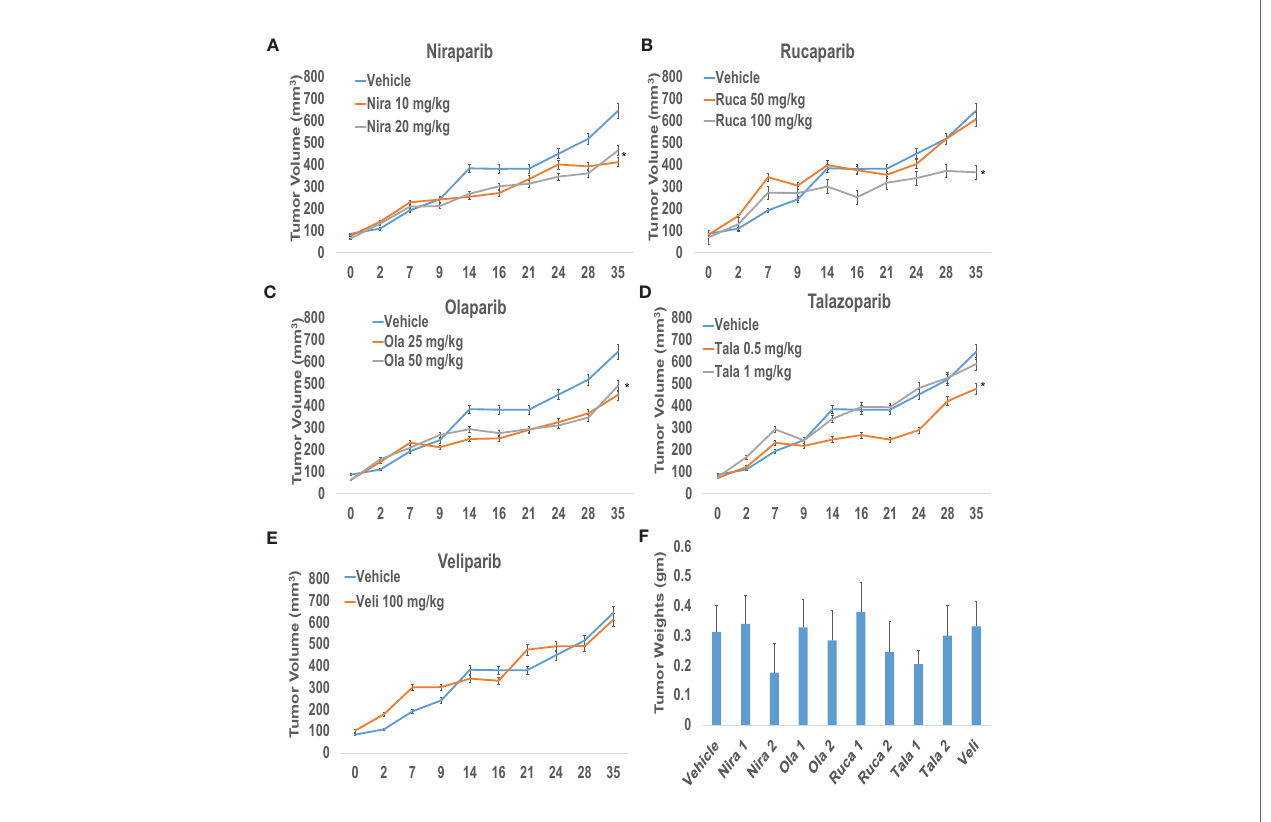
FIGURE 3 | PARPi suppressed RCC xenograft growth. RCC xenografts in both fl anks of male SCID mice (mouse n = 5; tumor n = 10) were treated via oral gavage with vehicle (0.5% Methocel A4M), or the indicated doses of PARPi: 10 or 20 mg/kg niraparib (A) ; 25 or 50 mg/kg olaparib (B) ; 50 or 100 mg/kg rucaparib (C) ; 0.5 or 1 mg/kg talazoparib (D) ; or 100 mg/kg veliparib (E) . Tumor volumes were measured twice weekly with digital calipers. Values are presented as average tumor volumes ± SD. P < 0.05 was considered signi fi cant (*). Tumor weights at the end of the experiment were measured (F) . Both doses of niraparib and olaparib along with one dose each of rucaparib and talazoparib were effective in reducing the growth rate of RCC xenografts. Veliparib was not able to reduce RCC tumor xenograft